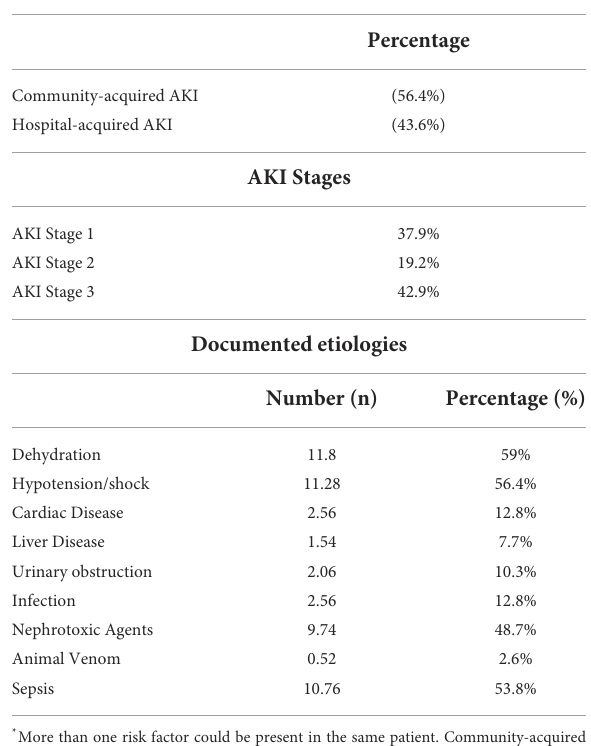
(Table 2), and the mean number of correctly staged cases